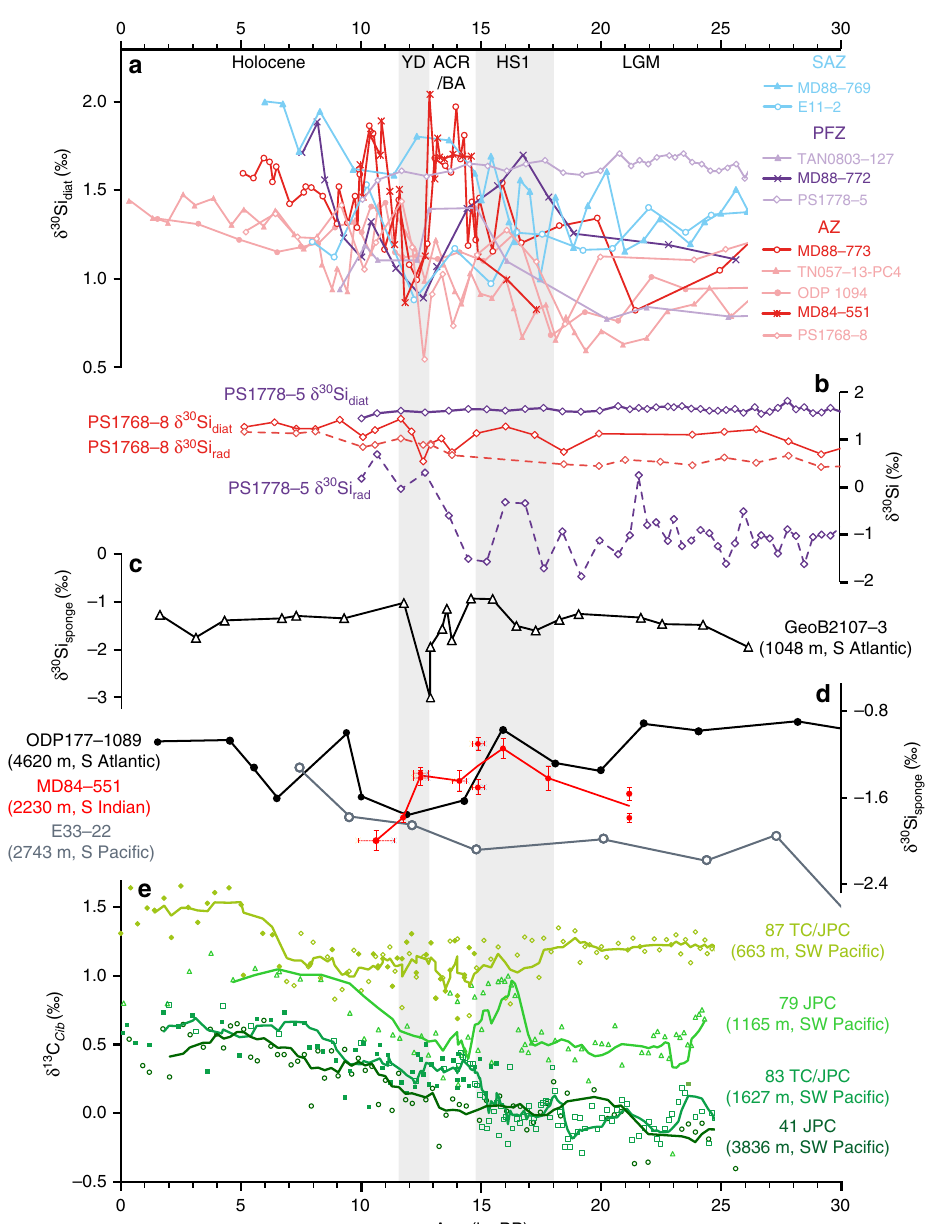
Fig. 3 A global compilation of silicon isotope data demonstrating the reorganisation of the DSi distribution across the last deglaciation. a Diatom silicon isotope ( δ 30 Si diat ) records from the Antarctic Zone (red), Polar Front Zone (purple) and Subantarctic Zone (blue). MD88-769 33 . E11-2 & ODP1094 35 . TAN0803-127 95 . PS1778-5 & PS1768-8 44 . TN057-13-PC4 34 . b Diatom ( δ 30 Si diat ) and radiolarian ( δ 30 Si rad ) silicon isotope records from PS1768-8 and PS1778-5 in the Atlantic sector 44 reconstructing changes in the vertical DSi gradient in the upper Southern Ocean. c A sponge silicon isotope record ( δ 30 Si sponge ) from 1048 m in the South Atlantic 45 recording changes in DSi content within intermediate waters. d δ 30 Si sponge record from MD84-551 accompanied by records from the south Atlantic and south Paci fi c 47 . Vertical error bars display ±1SE. Horizontal error bars, where present, represent the age range of the samples used to produce the given data point. Together these δ 30 Si sponge records demonstrate the deglacial changes in deep ocean DSi gradients. e Four benthic foraminiferal ( Cibicidoides wuellerstor fi ) δ 13 C records from the southwest Paci fi c 18 highlighting the timing of ventilation changes in the Paci fi c across the last deglaciation. Solid and open symbols represent samples from jumbo piston and trigger cores, respectively. A map depicting the locations of all cores used in this fi gure can be found in Supplementary Fig.